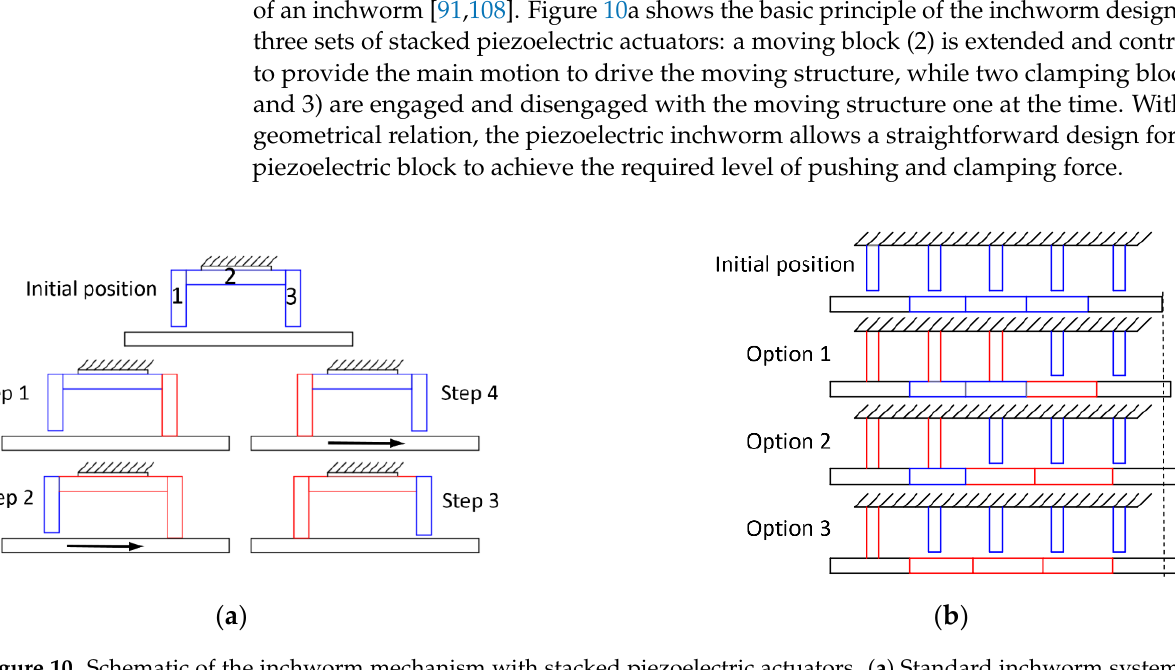
Table 4. Performance of a typical piezoelectric-based actuator.